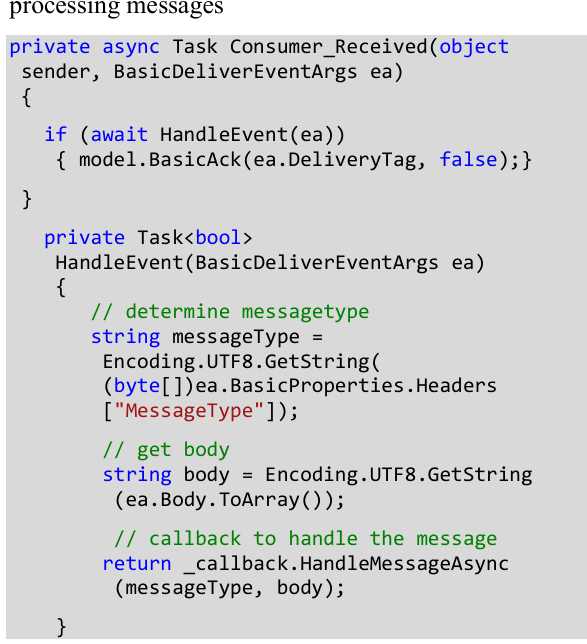
Figure 2. TaskApp